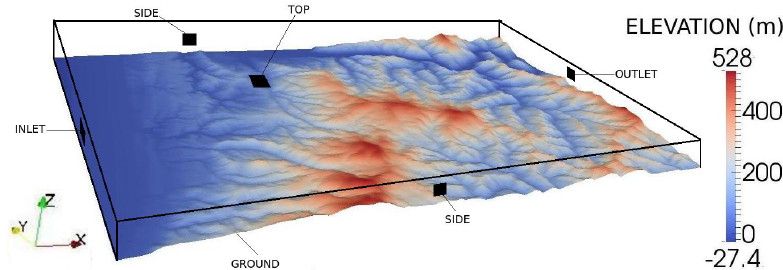
Figure 3. Computational domain and the colored ground is showing elevation above